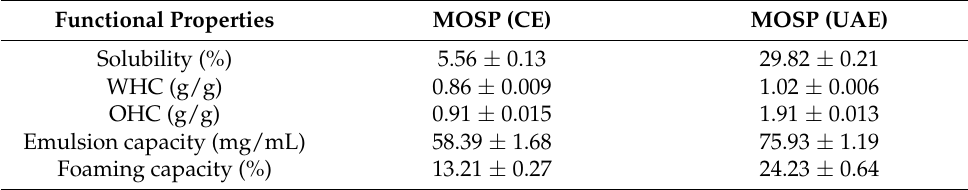
Emulsion capacity (mg/mL) Foaming capacity